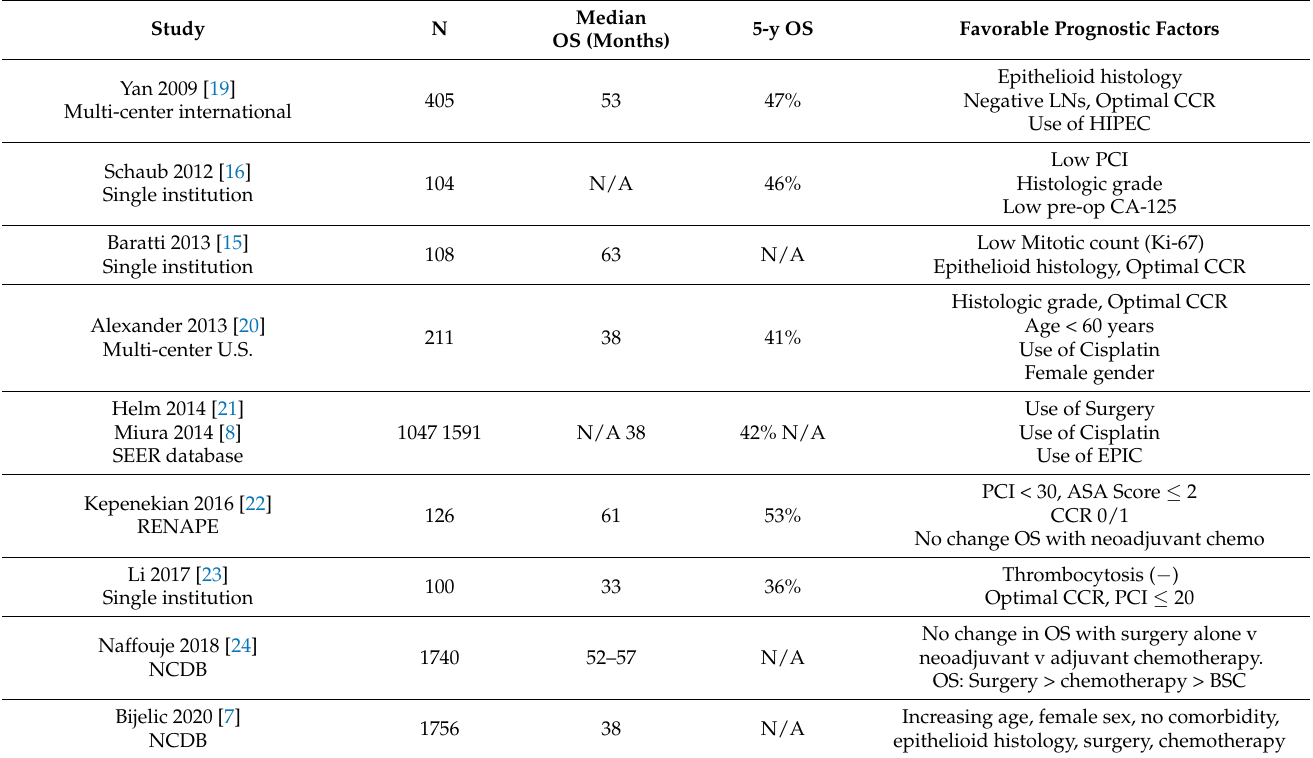
Table 1. Selected series of outcomes in MPM